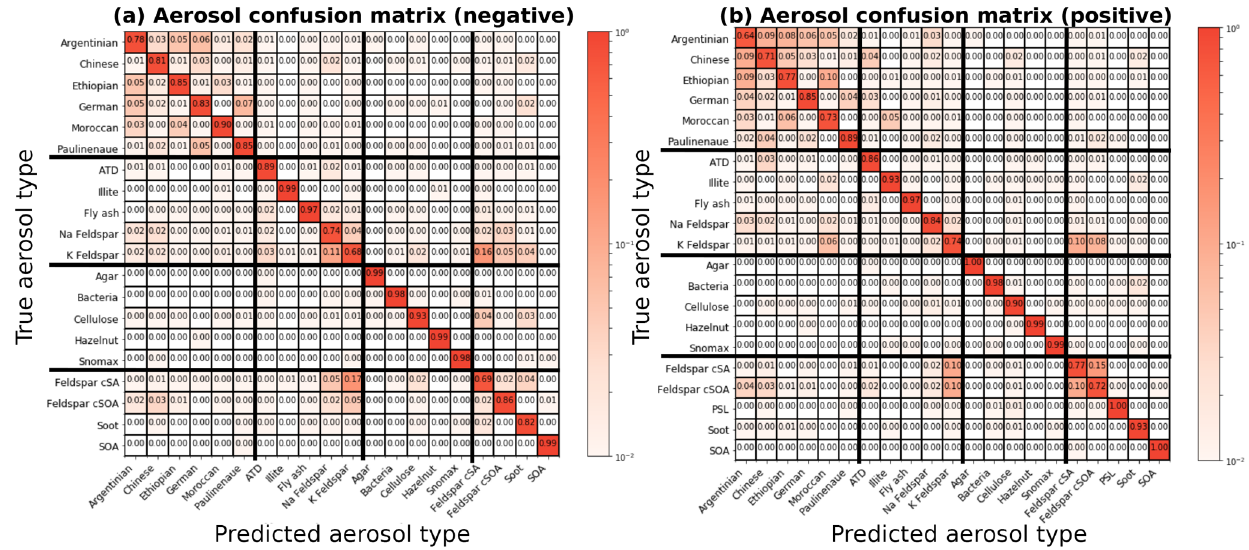
Figure 3. Column-normalized confusion matrices showing fraction of aerosols labeled as j that belong to i , where i and j are row and column indices, respectively. Confusion matrices are determined from training data of known origin and are used to compute probability distributions. Aerosol types (Table 1) are grouped into four broad categories delineated by the bold horizontal and vertical bars. From top to bottom or left to right: fertile soils, mineral/metallic, biological, and other. Classification accuracy, the average probability of a correct aerosol prediction across all labels, is computed by averaging diagonal matrix elements. For all aerosol types, the accuracy is 87% in positive ion mode and 87% in negative ion